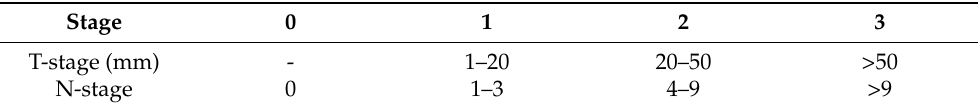
Table 1. Definitions of tumour stages and stage shift used in the simulation. Stage 0 1 2 3 T-stage (mm)